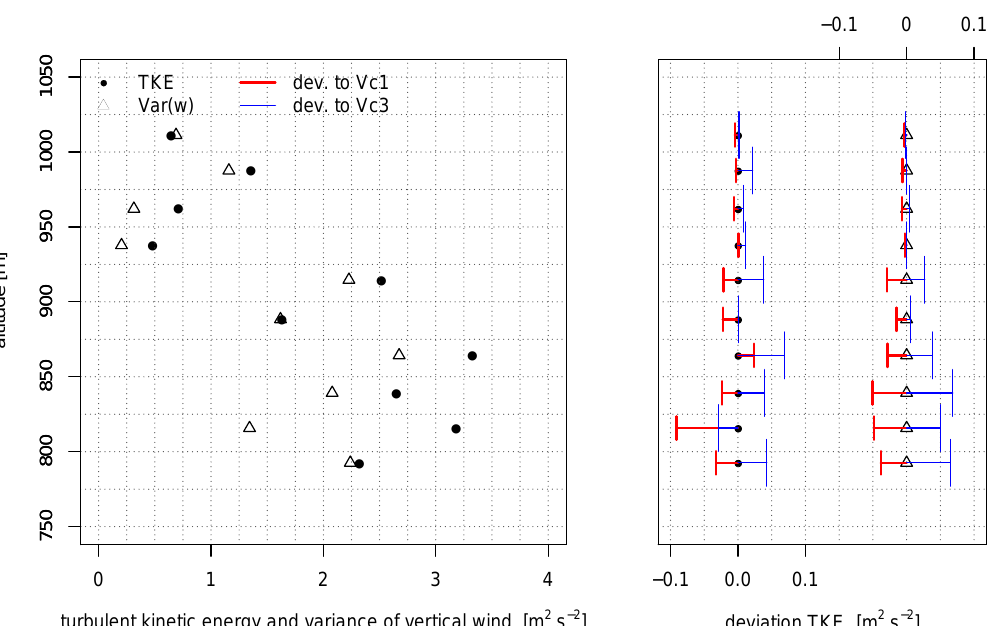
Figure 11. Height profiles of the COMPLEX flight with the altitude AMSL of the turbulent kinetic energy TKE and the variance of the vertical wind component Var( w ), calculated with the calibration polynomial at v c 2 ( left ). Deviations ( right ), when applying the calibration polynomials at v c 1 and v c 3